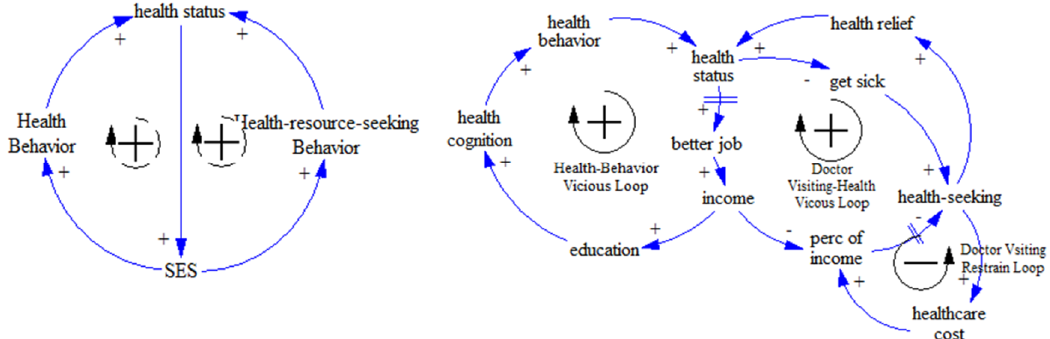
Figure 1. Causal loop of socioeconomic status (SES)–health disparity.